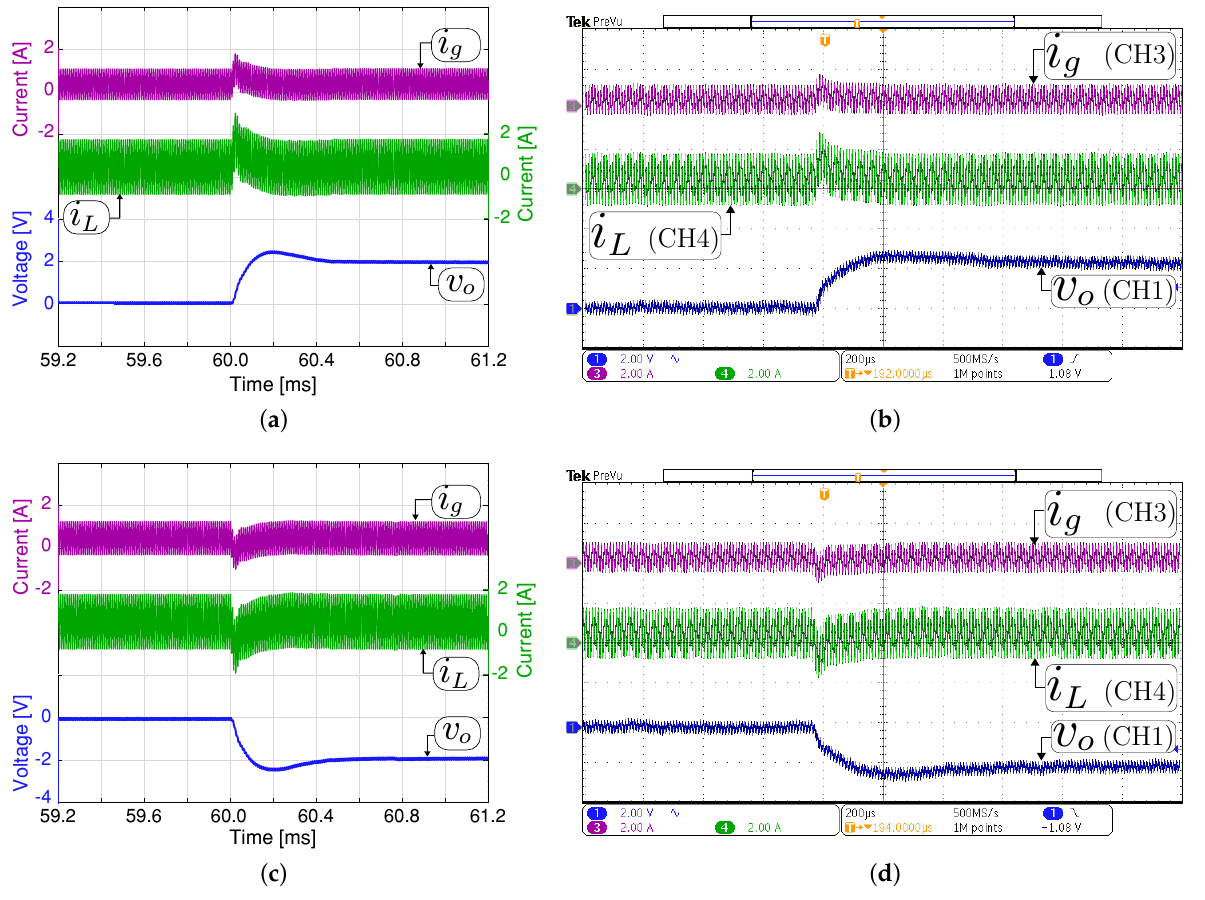
Figure 9. Small signal transient response with a constant resistive load R o = 200 Ω in buck mode ( V g = 200 V). Simulated ( a , c ) and experimental ( b , d ). Transient response when the output voltage reference changes from 98 to 100 V ( a , b ), and from 100 V to 98 V ( c , d ). CH1: v o (2 Vac/div), CH3: i g (2 A/div), CH4: i L (2 A/div), and time base of 200 µ